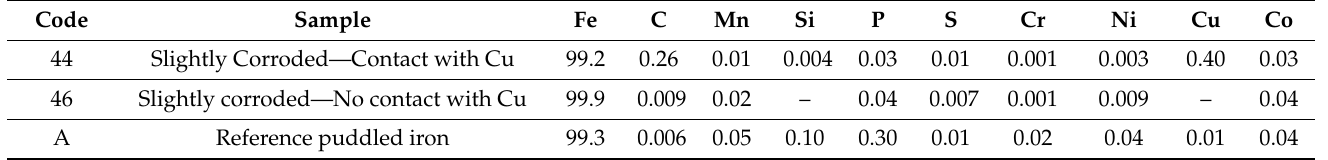
Table 2. Bulk alloy composition of iron samples (wt.%) obtained by GDOES